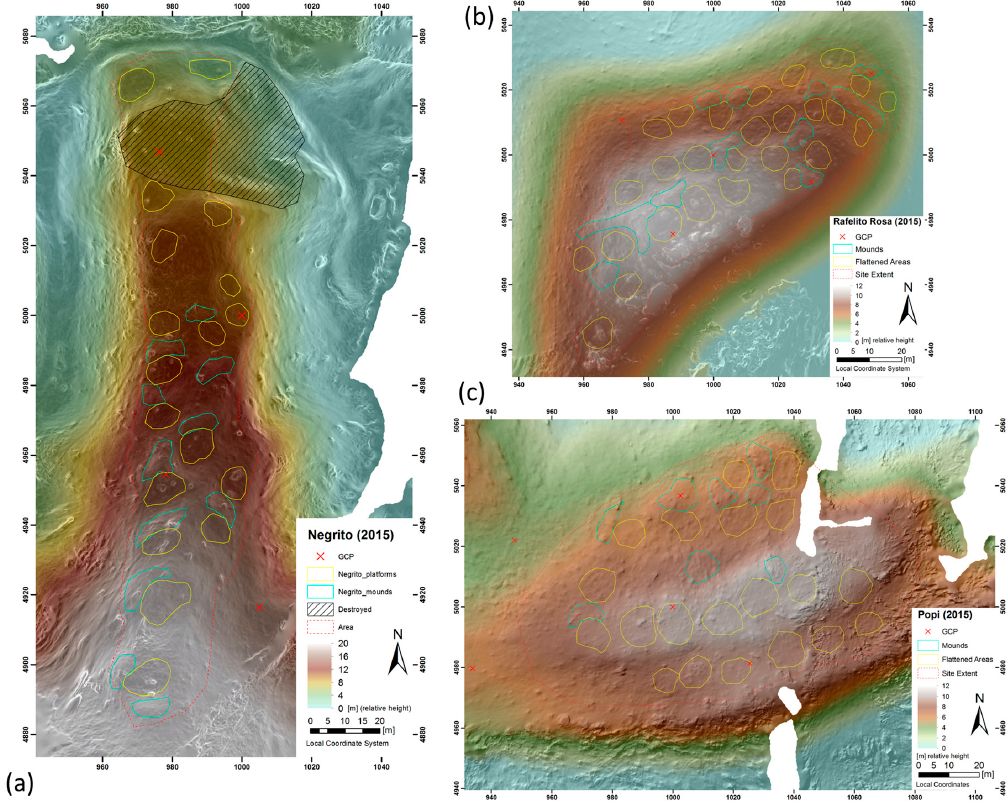
Figure 5. The three sea-facing smaller settlement sites. Particularly at ( a ) Negrito and ( b ) Rafelito Rosa are the flattened areas highlighted by the DEM-hillshade combination, while at ( c ) Popi the stronger vegetation complicated the extraction for features. Compared to the flattened areas (yellow), the mounds (mint) are more difficult to distinguish.